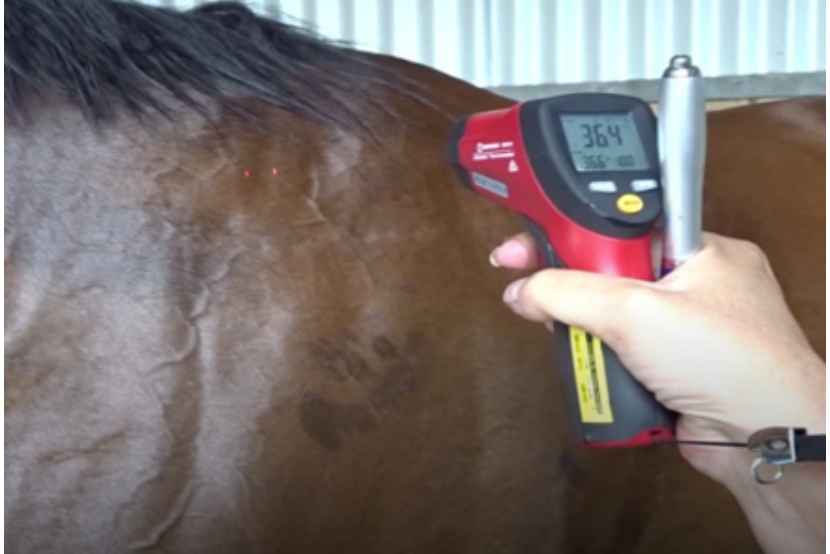
Figure 15. An experienced veterinary worker can subjectively assess skin surface temperature. Source—J Equine Vet Ed, 2021.